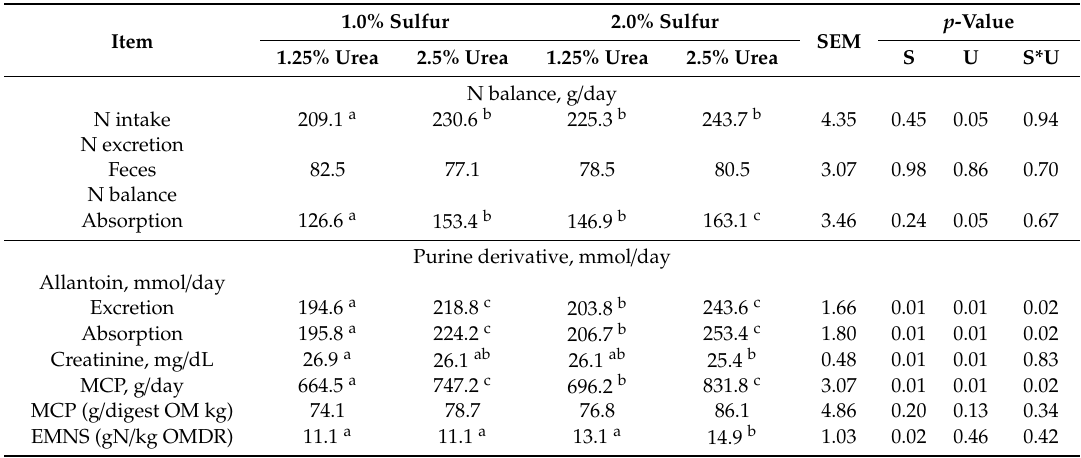
Table 4. E ff ect of fermented total mixed ration supplementation on nitrogen (N) balance and purine